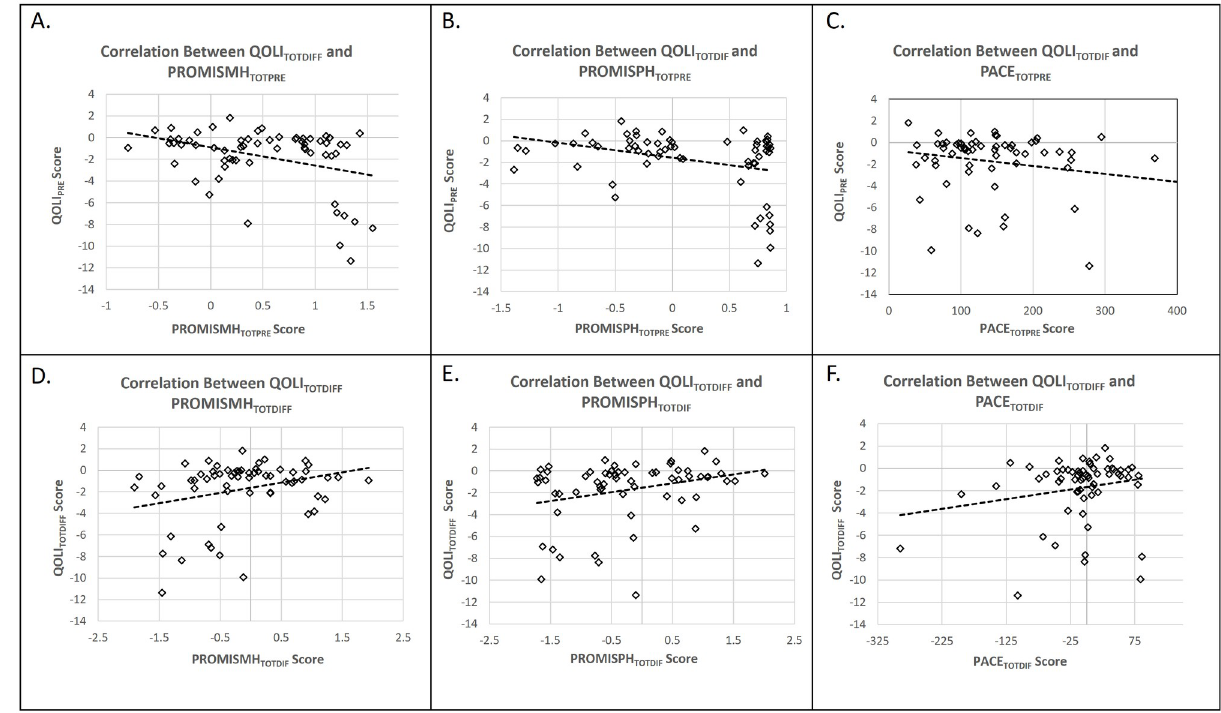
Fig 5. ( A-C ) Plots showing the relationship between baseline PROMIS mental/physical health summary scores and PACE scores and changes in QOLI. ( D-F ) Plots showing the relationship between changes in the PROMIS mental/physical health summary scores and PACE scores and changes in QOLI.